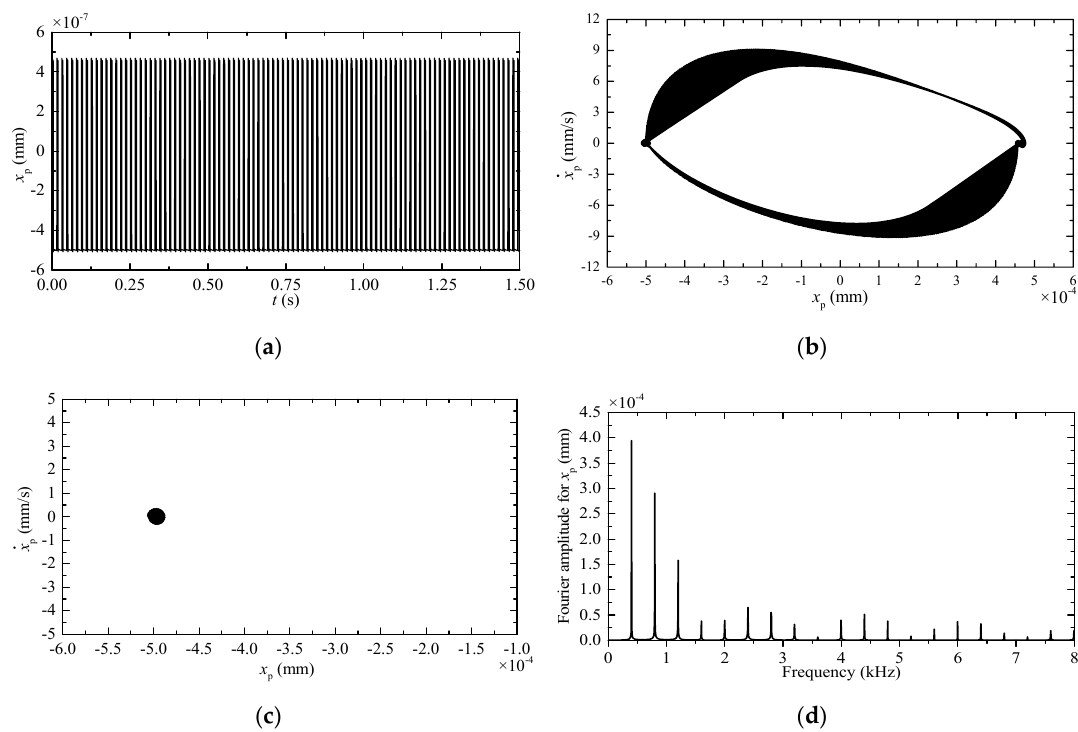
Coatings 2019 , 9 , x FOR PEER REVIEW E E = ) along OLOA is analyzed by comparing the ( a) Figure 7. The vibration response of pinion ( Figure 7. The vibration response of pinion ( E c = E s ) along OLOA is analyzed by comparing the c s time-history curve, (b) phase curve, (c) Poincare map, and (d) FFT spectrum. ( a ) time-history curve, ( b ) phase curve, ( c ) Poincare map, and ( d ) FFT spectrum.